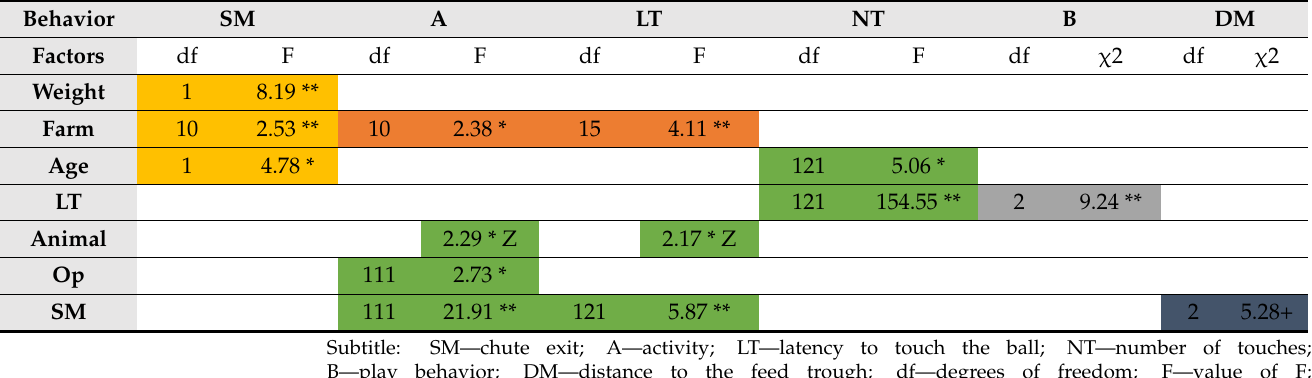
Table 4. Summary of the results of the analysis on the different behaviors according to various models.